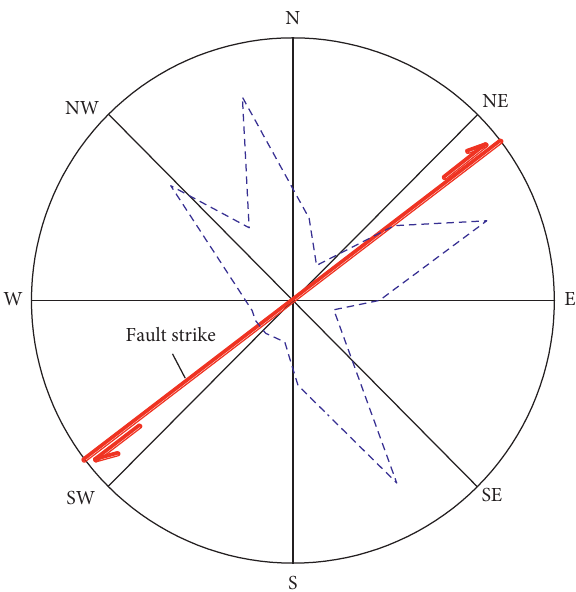
Figure 5: Rosette diagram of sliding directions of large-scale landslides in Hongshihe basin of Qingchuan county [2].